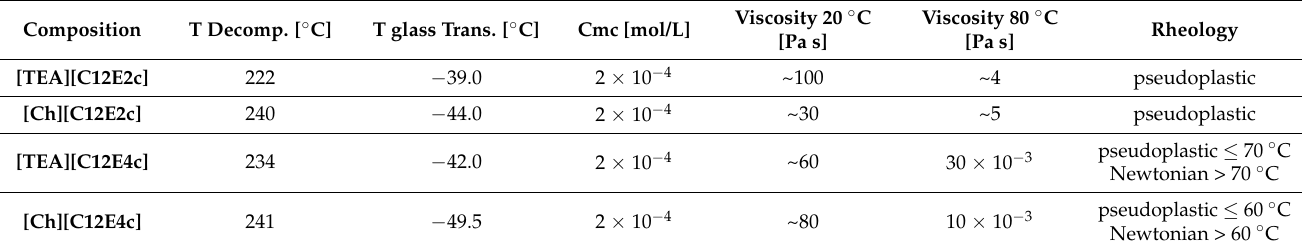
Table 1. Decomposition temperature, glass transition temperature, and viscosities at two temperatures for the four salts (SAILs) considered, together with their rheological behavior. For aqueous Scheme 15.